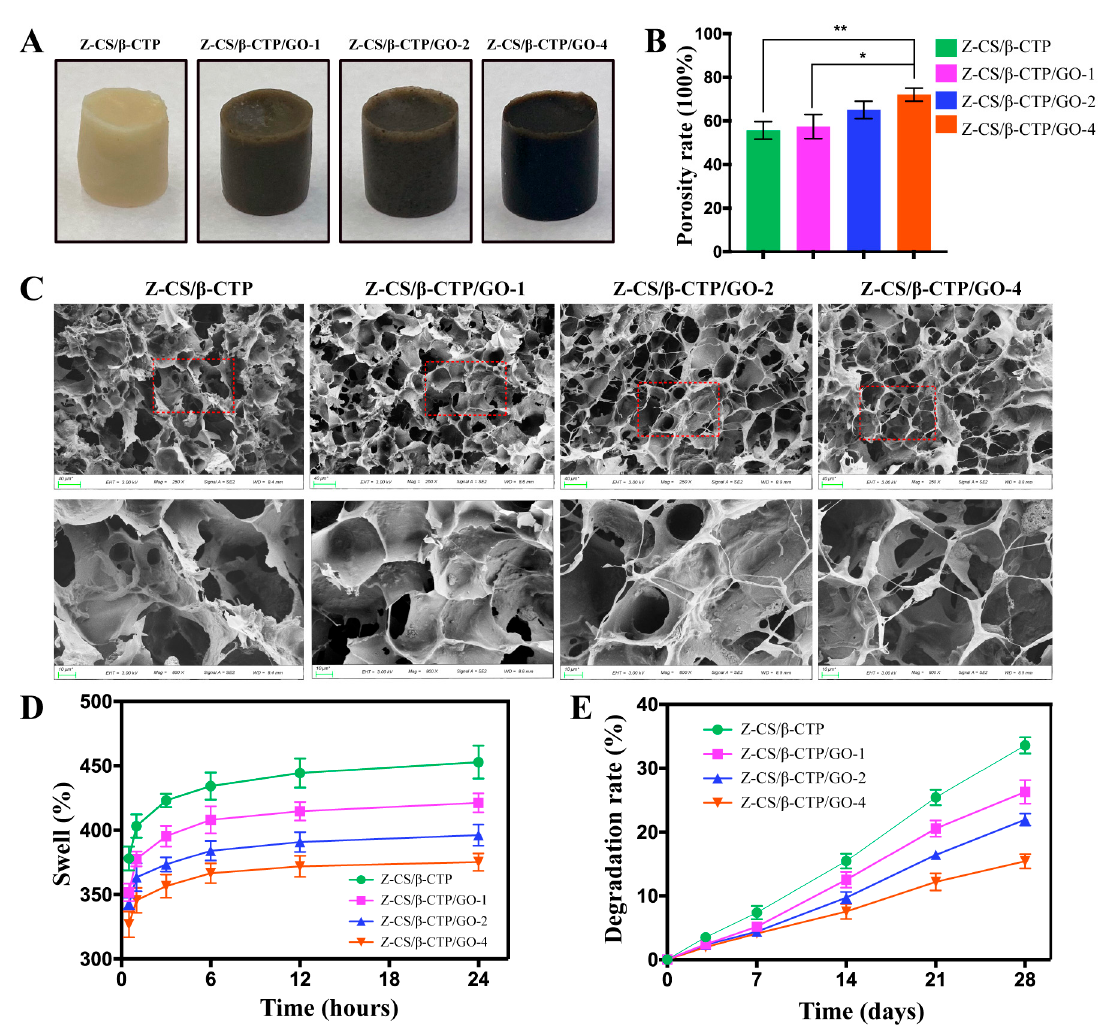
Figure 1. ( A ) Optical images of hydrogels. The color changed gradually from milky white to black with the increase of GO concentration. ( B ) Pore sizes of different scaffolds increased with the increase of GO concentration (* p < 0.05, ** p < 0.01). ( C ) SEM images of scaffolds with different concentrations of GO. The red dotted boxes in the upper panels were enlarged in the lower panels. ( D ) Swelling rate and ( E ) degradation rate decreased with increasing GO concentration.